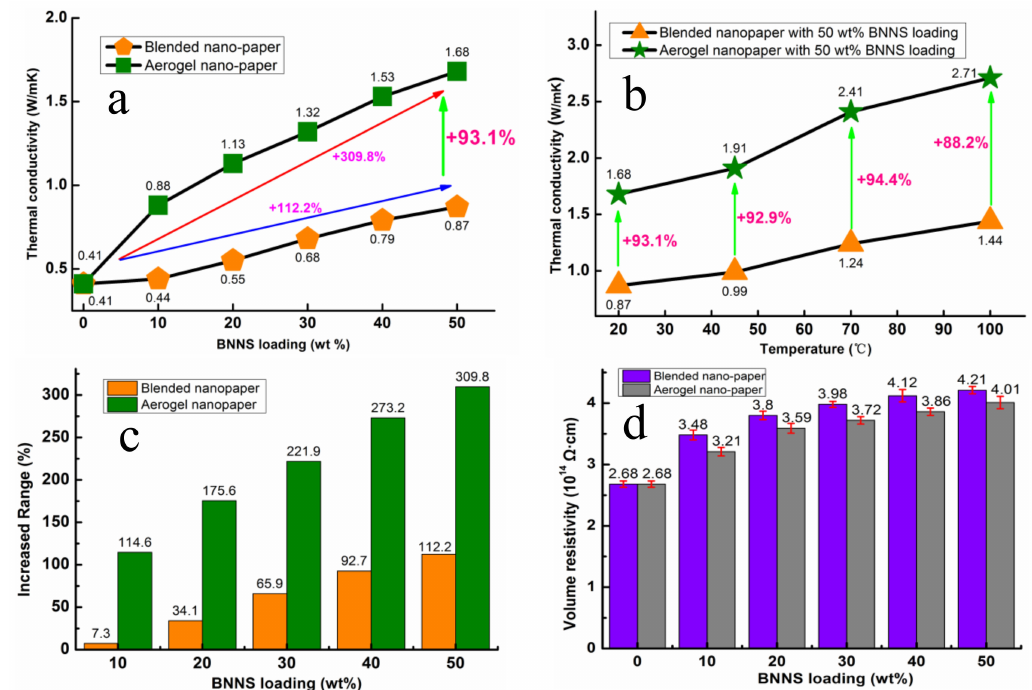
Figure 5. ( a ) Thermal conductivity of BNNS / CNF nano-paper, ( b ) The e ff ects of temperature on BNNS / CNF nano-paper, ( c ) Increased range of thermal conductivity at 20 ◦ C, ( d ) The e ff ects of BNNS loading on volume resistivity of nano-paper.